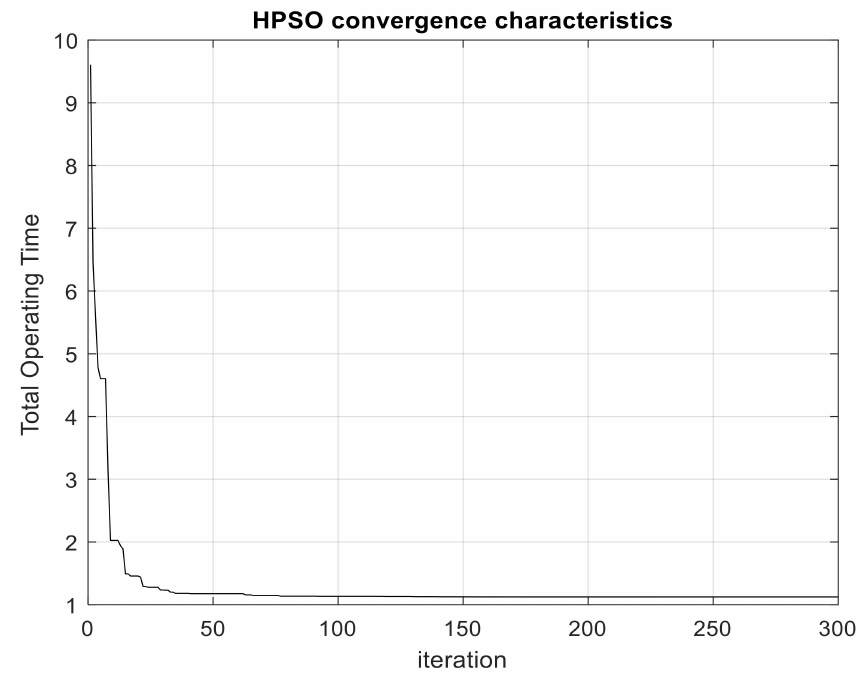
Figure 9. Convergence characteristic graph of OF (2) (Case